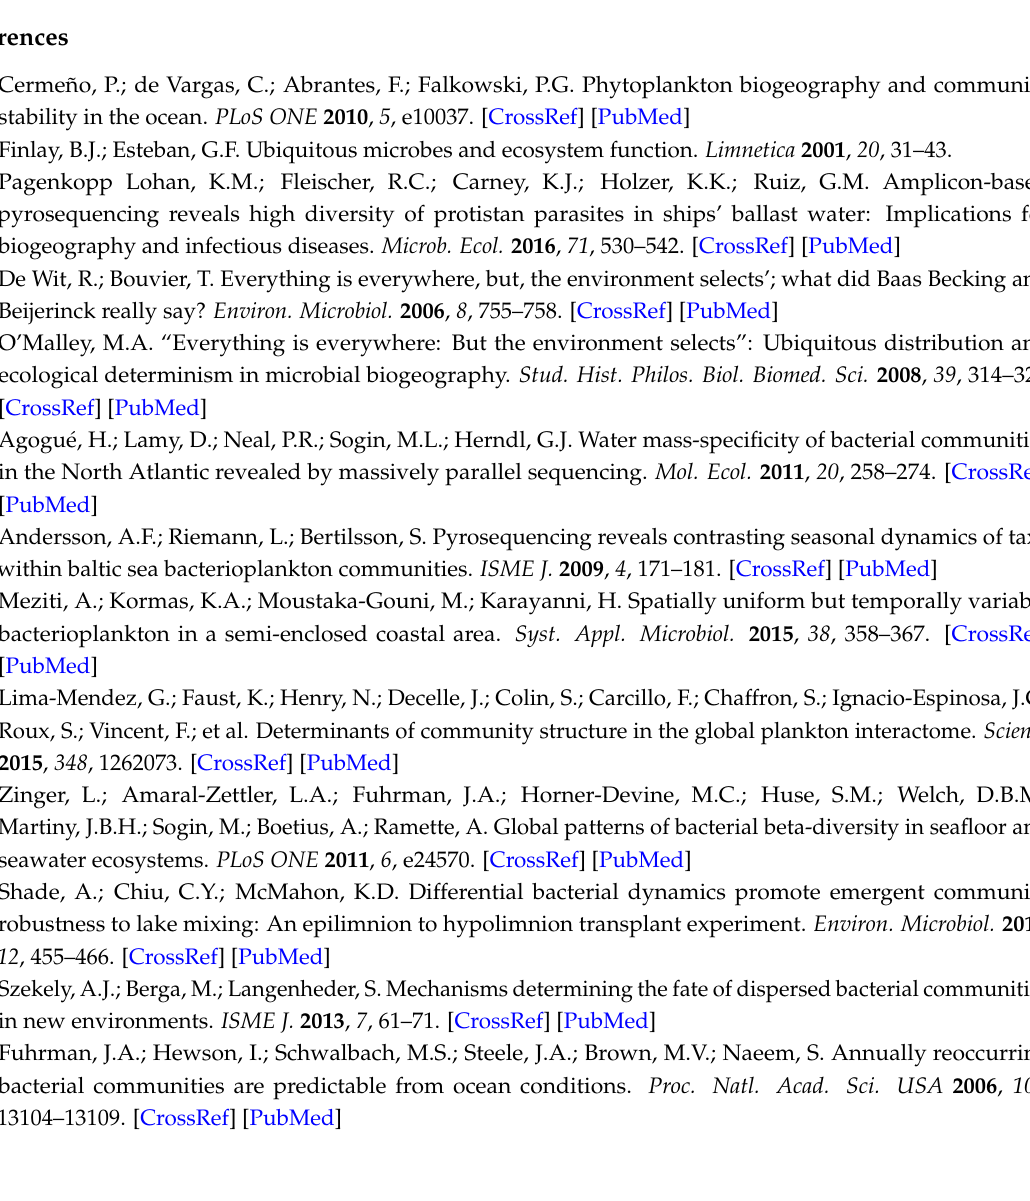
Figure S1: Venn Diagram at distance 0.03, illustrating the number of unique and shared bacterial and archaeal (in parenthesis) OTUs (97% sequence similarity) among Banyuls (B), Woods Hole (W) and Pagasitikos (P) microcosms at d0 (top), d5 (middle) and d17 (bottom); Table S1. Bacteria (cumulative >70%) and Archaea (cumulative >80%) OTUs and families/phyla relative abundance. Bold: dominant